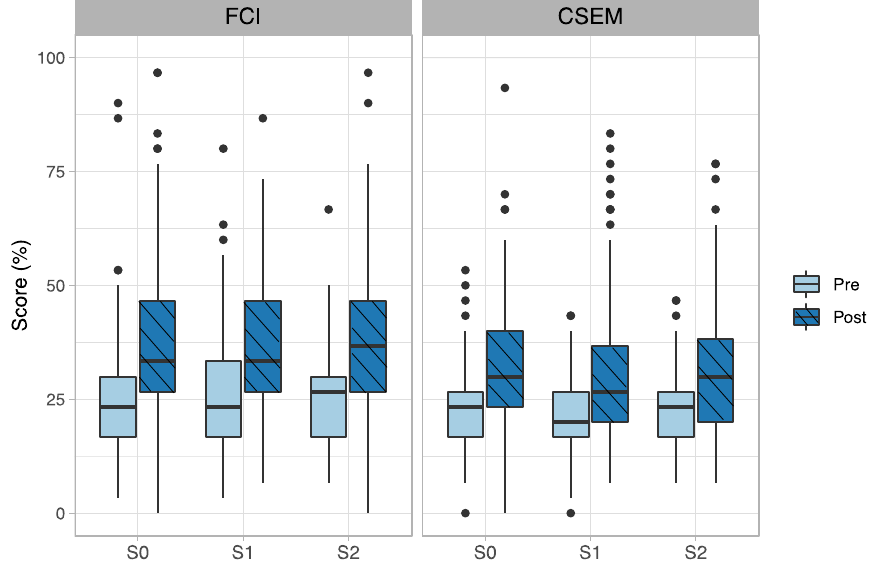
FIG. 10. Undergraduate student pretest and posttest scores on FCI and CSEM across semesters. There is no difference in student learning as measured by FCI and CSEM across